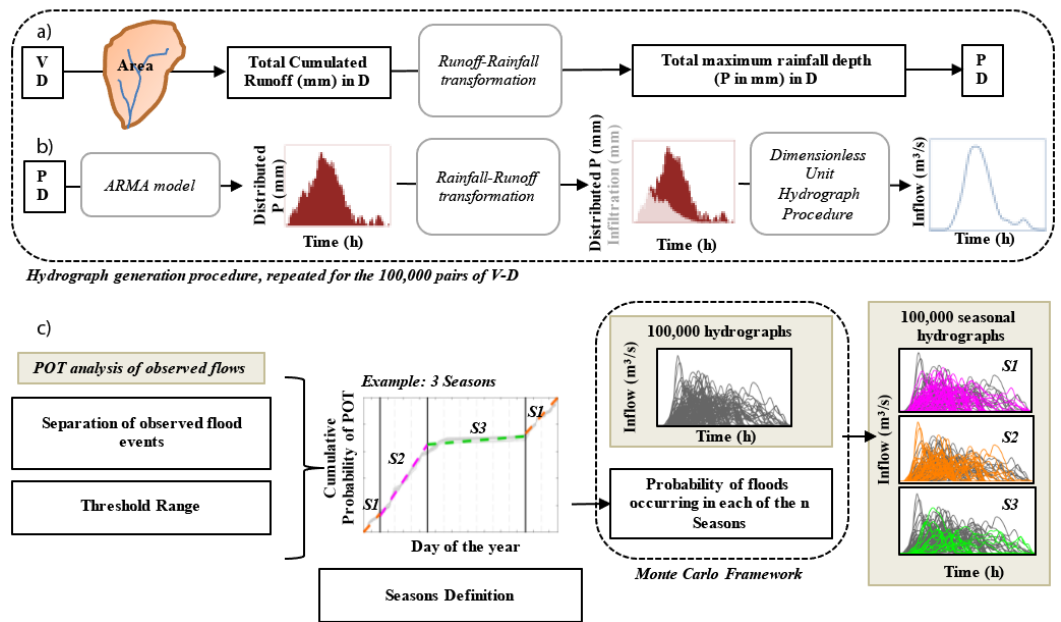
Figure 3. The procedure to generate the ensemble of inflow hydrographs ( a , b ) and its seasonal characterization ( c ). D represents the flood durations, whereas V represents the maximum annual flood. S1, S2, and S3 represent the different seasons.